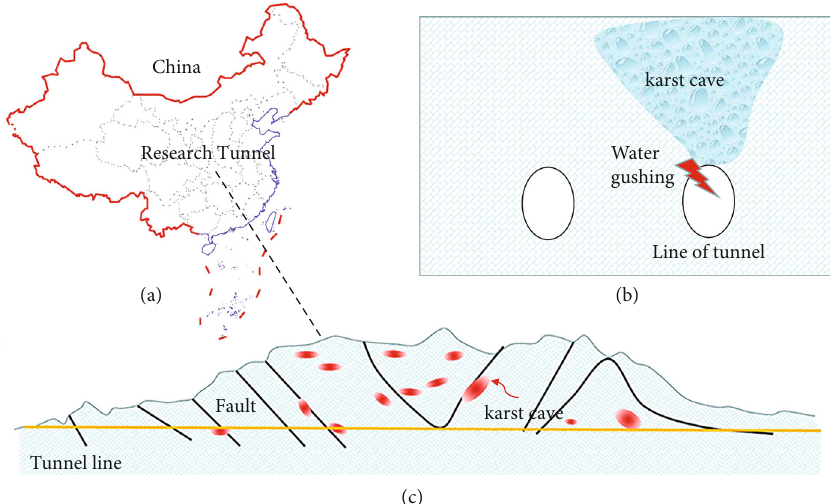
Figure 1: Overview of research target tunnel.